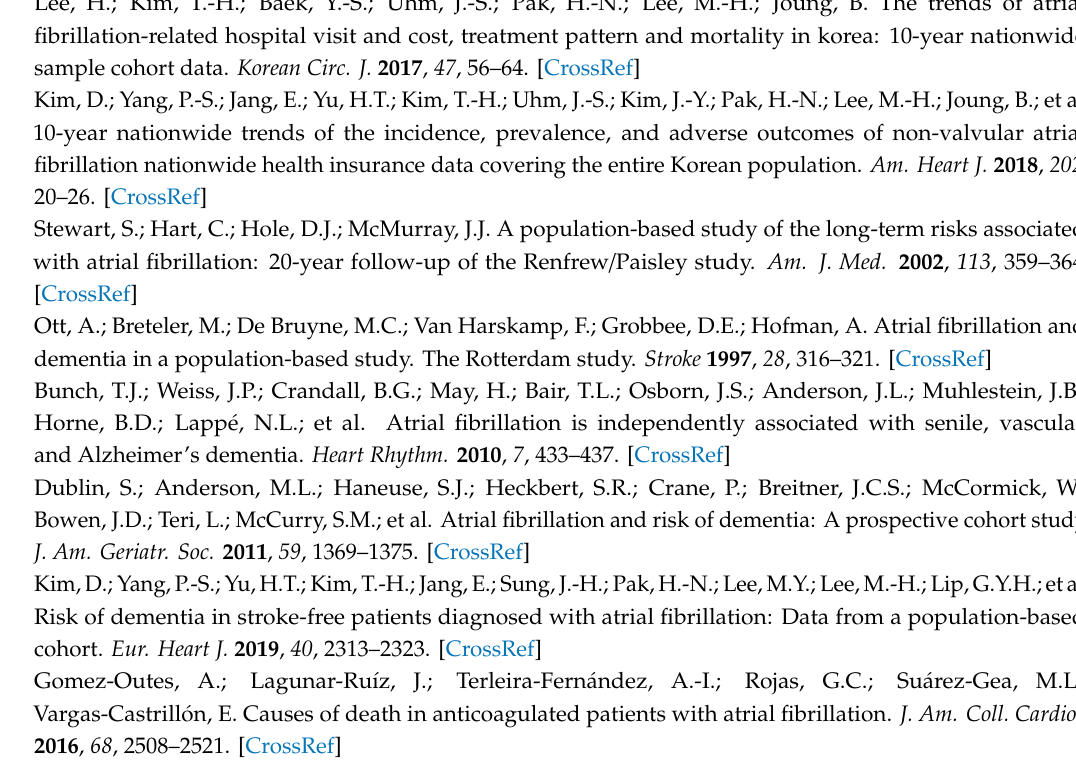
Supplementary Table S1: Definitions and ICD-10 codes used for defining the comorbidities and clinical outcomes. Supplementary Table S2: Comparison of baseline characteristics between atrial fibrillation patients compliant with and without ABC pathway. Supplementary Figure S1. The ABC pathway for integrated care